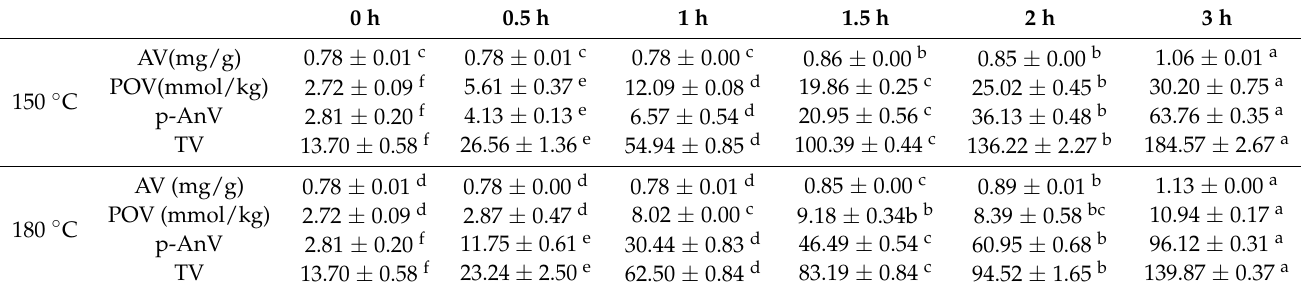
Table 4. Changes in AV, POV, p-AnV and TV of HOSFO&SSO oil blend during heating.